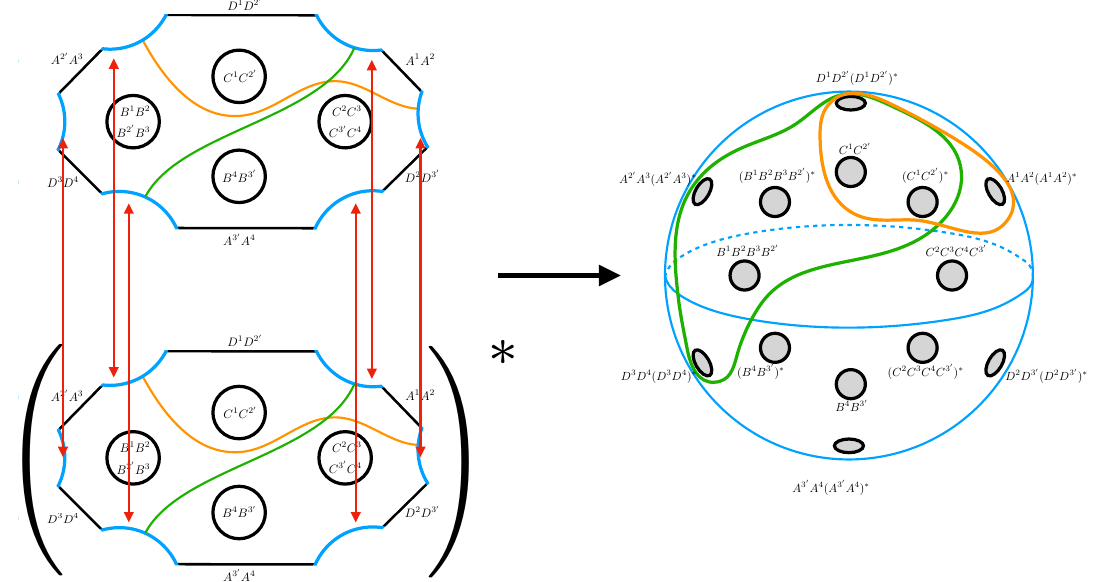
Figure 4 . M 0 and its CPT conjugate M ∗ are glued along the open ( A, D ) geodesics to form the final 0 manifold M on which the geodesics that correspond to E W surfaces of the original entanglement wedge are closed